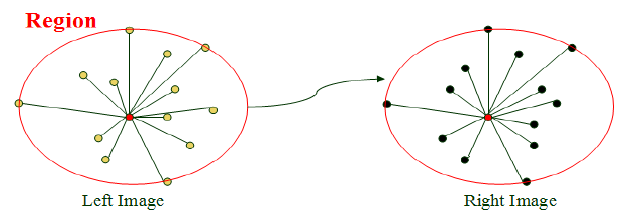
Figure 9. Candidate prediction in a region. The red point is a seed point; the remaining points marked in yellow are predicted on the right image. The points marked in black are the predicted